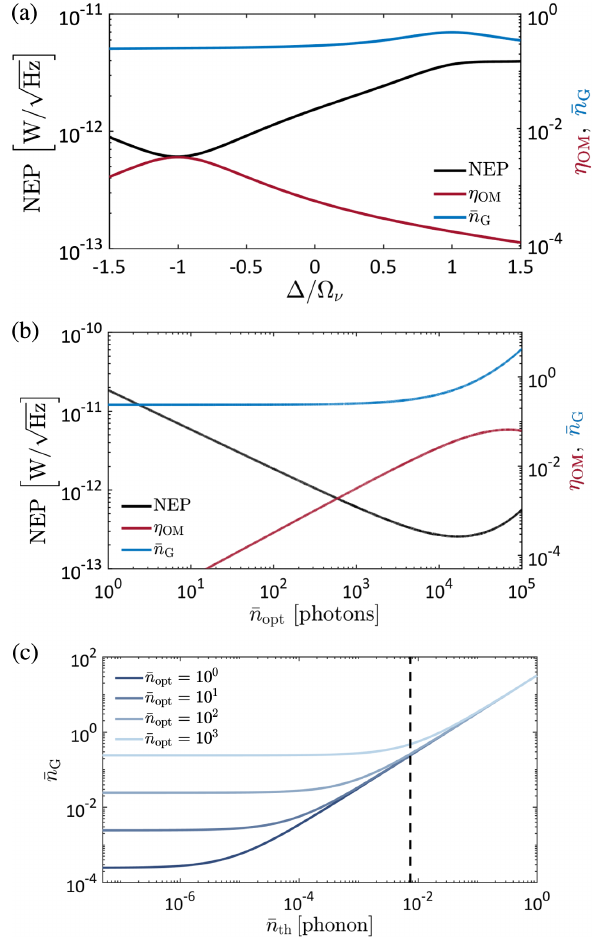
FIG. 3. (a),(b) Left axis: Noise-equivalent power (NEP) (black solid line); right axis: Power-dependent part of the internal ¯ n conversion efficiency η (red solid line) and noise- OM ð opt Þ equivalent photon number per gate ¯ n (blue solid line) plotted G on a logarithmic vertical scale (a) as a function of the detuning of the optical pump laser with respect to the plasmonic resonance for 1000 and a fixed intracavity optical photon number ¯ n opt ¼ (b) plotted as a function of intracavity optical photon number ¯ n for a fixed optimal red detuning Δ ¼ − Ω ν . We use the opt parameters for the dual antenna and molecular system described in the text.Alltheirnumerical valuescan befound inthe Appendixes. (c) ¯ n as a function of the thermal occupancy of the vibrational G mode for several intracavity optical photon numbers. The dashed vertical line denotes the thermal occupancy of the mode consid- ered in the text ω ν = ð 2 π Þ ¼ 30 THz at room